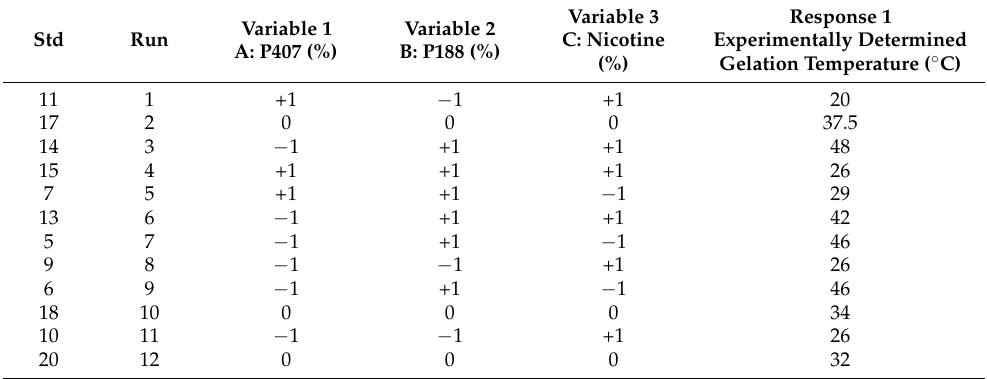
Table 2. Second screening design showing variables (in coded values) and